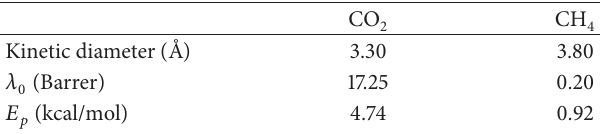
Table 3: DM sorption model parameters for carbon dioxide sorbed in polyimide.